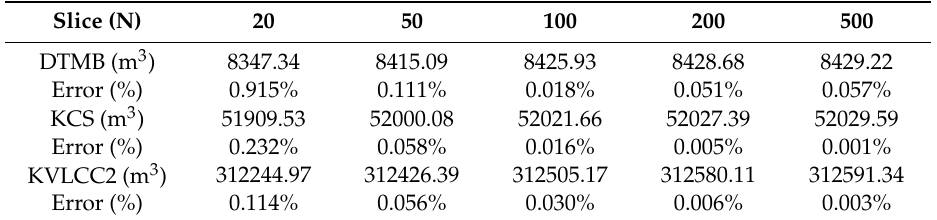
Table 3. Comparison of hull volumes.